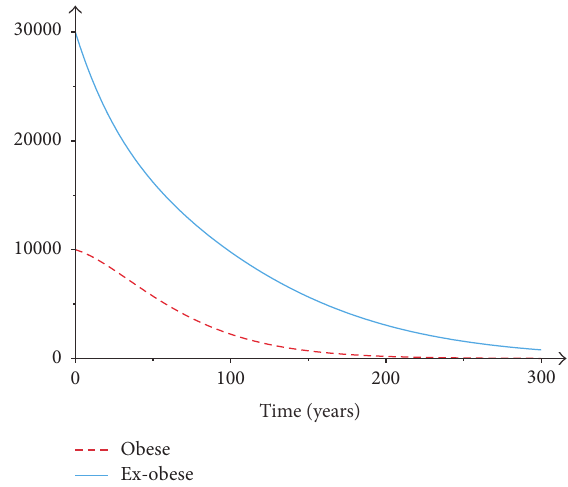
Figure 12: Infected (obese) and recovered (ex-obese) individuals as function of time. Here 𝜖 = 0 , 𝑅 0 = 0.8 , and the initial condition is (𝐼(0), 𝑅(0)) = (30000, 12000) .